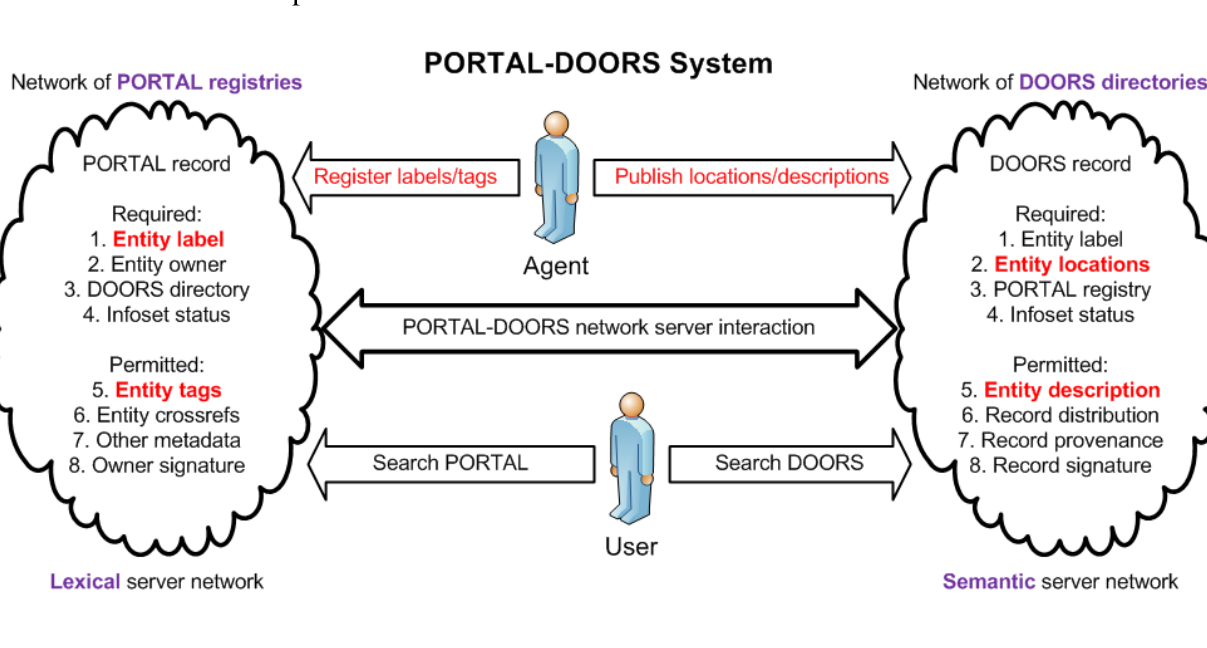
Figure 2. PORTAL-DOORS System Data Records: Resource metadata is registered